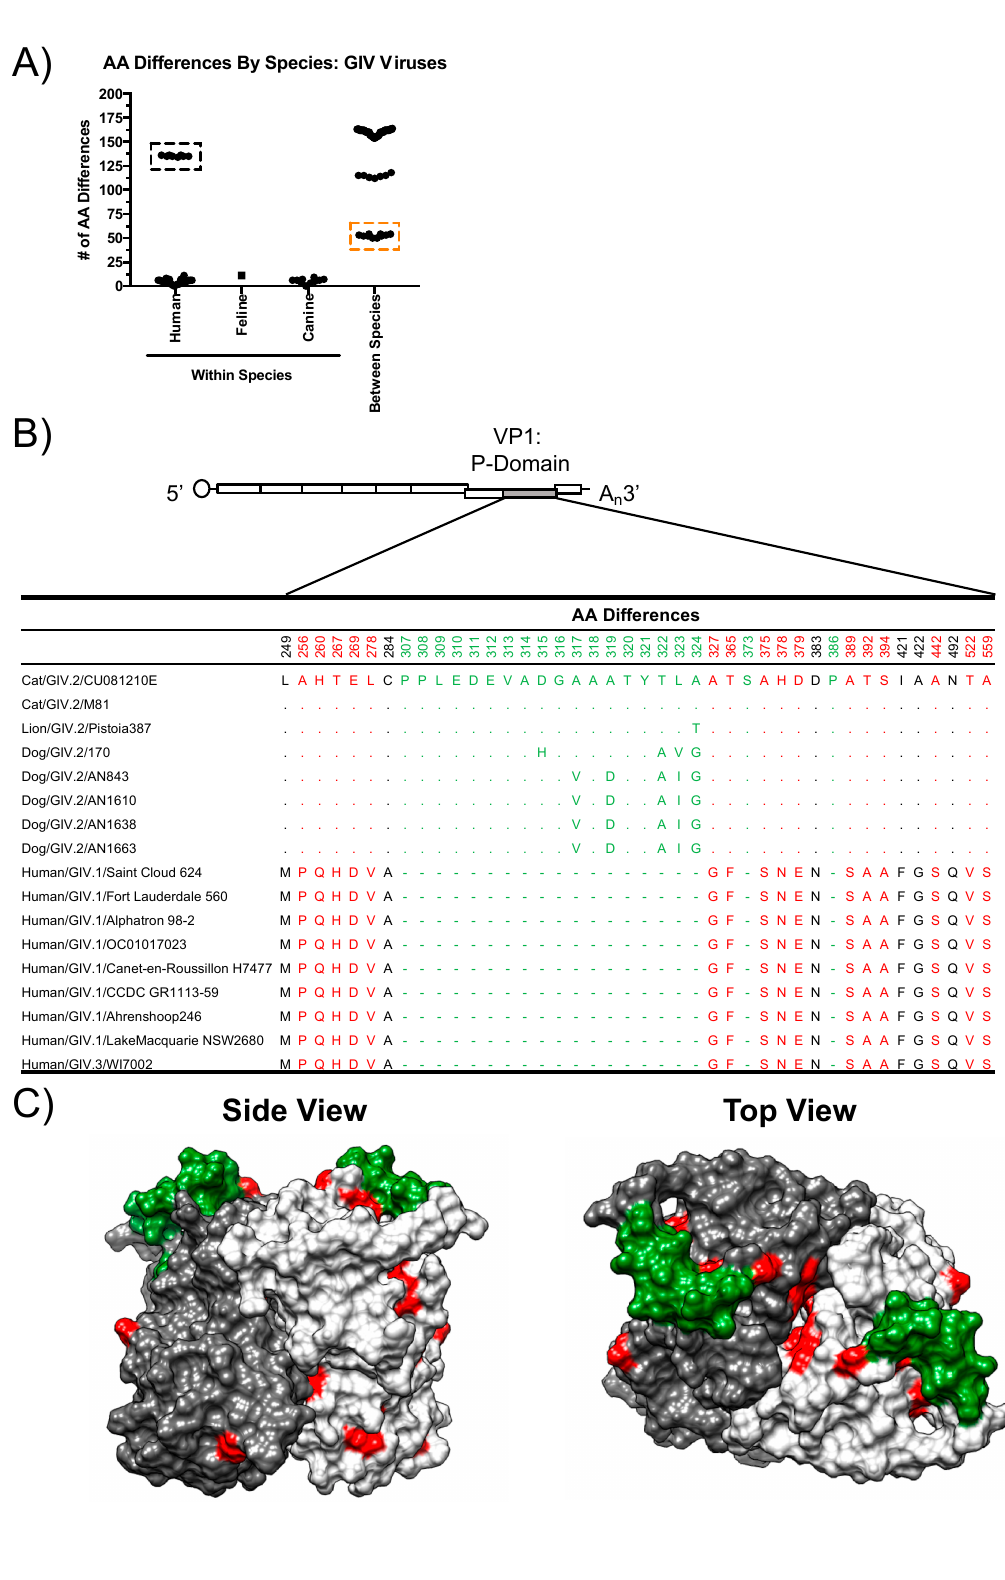
7 of 16 was previously identified in a feline norovirus strain [32]. All canine and feline noroviruses within GIV.2 and GVI share this insertion near the top of the structure, in contrast to the human GIV.1 and